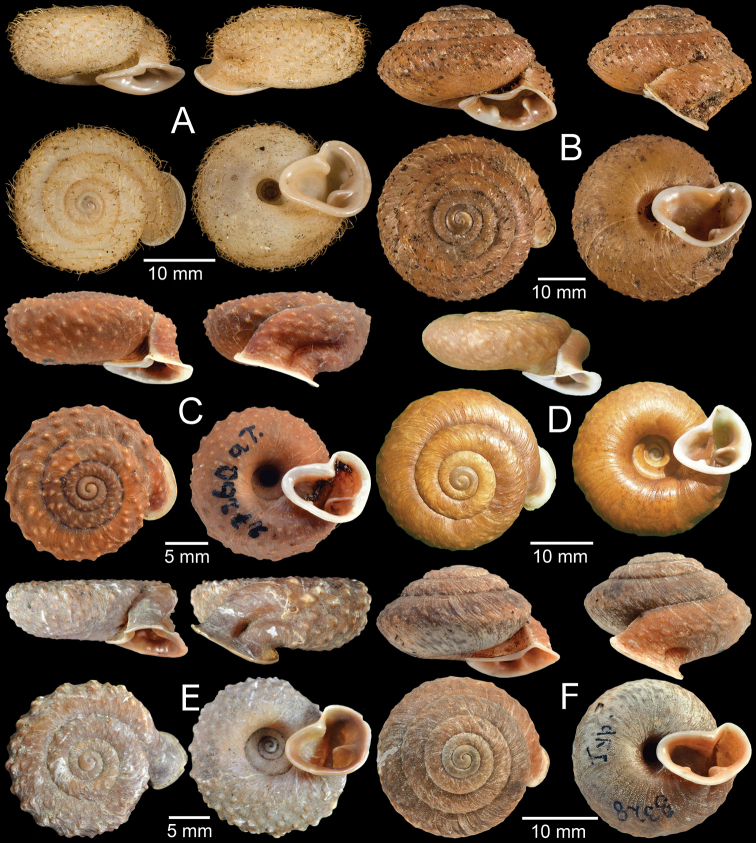
AMoellendorffia
blaisei, syntype MNHN-IM-2000-1843 BMoellendorffia
callitricha, syntype MNHN-IM-2000-2006 CMoellendorffia
spurca
deflexa, lectotype SMF 27260a DMoellendorffia
dengi, holotype ZMHN AIMS 1693 EMoellendorffia
depressispira, syntype MNHN-IM-2000-34941 FMoellendorffia
eastlakeana, lectotype SMF 8328/1. Photo: J He (D).